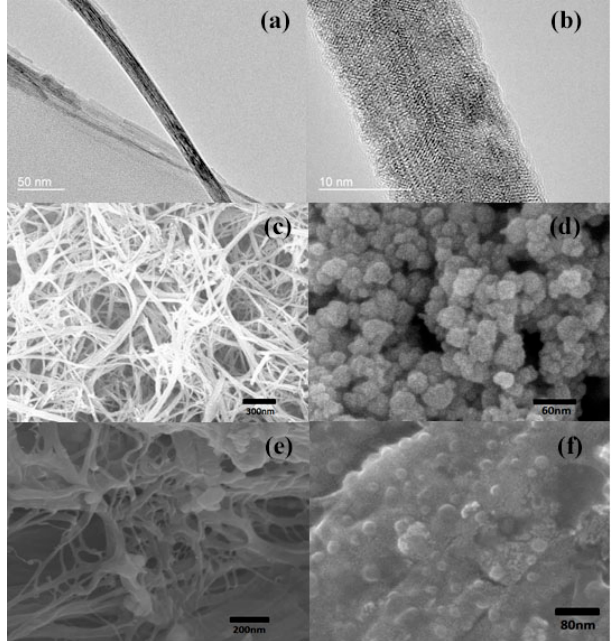
Figure 1. The TEM images of BT nanowires ( a , b ); SEM micrographs of powders of BT nanowires ( c ); and BT nanoparticles ( d ); Cross sections of P(VDF–TrFE)–BTNW nanocomposites with 10% volume fraction of BT nanowires ( e ); and 10% volume fraction of BT nanoparticles ( f ).